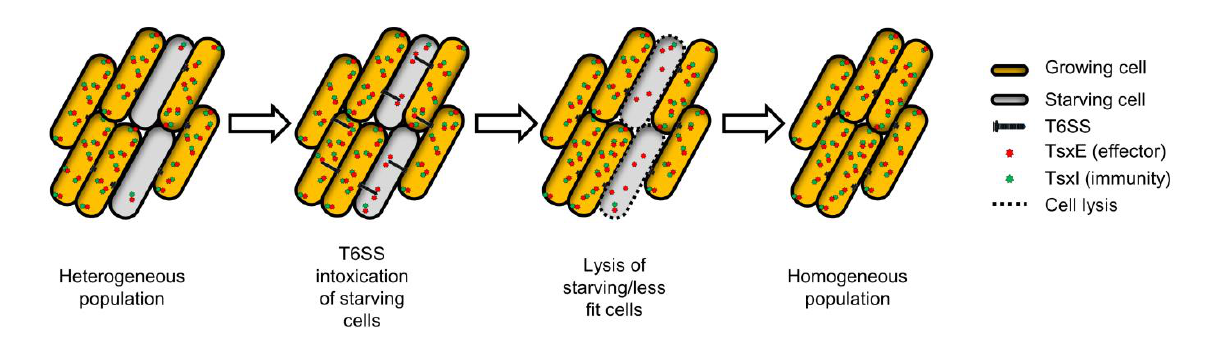
FIGURE 1: Model for how M. xanthus eliminates starving/less fit cells from a physiologically heterogeneous population through T6SS attack. M. xanthus population is initially depicted as a mixture of growing and starving cells. Starving cells have lower levels of TsxEI and therefore are susceptible to TsxE intoxication. T6SS is expressed at elevated levels in growing cells and TsxE is delivered to neighboring sib- lings. As a consequence, starving cells are intoxicated, lysed, and removed from the population. This results in increased physiological ho- mogeneity and improved fitness of the population to conduct coordinated multicellular